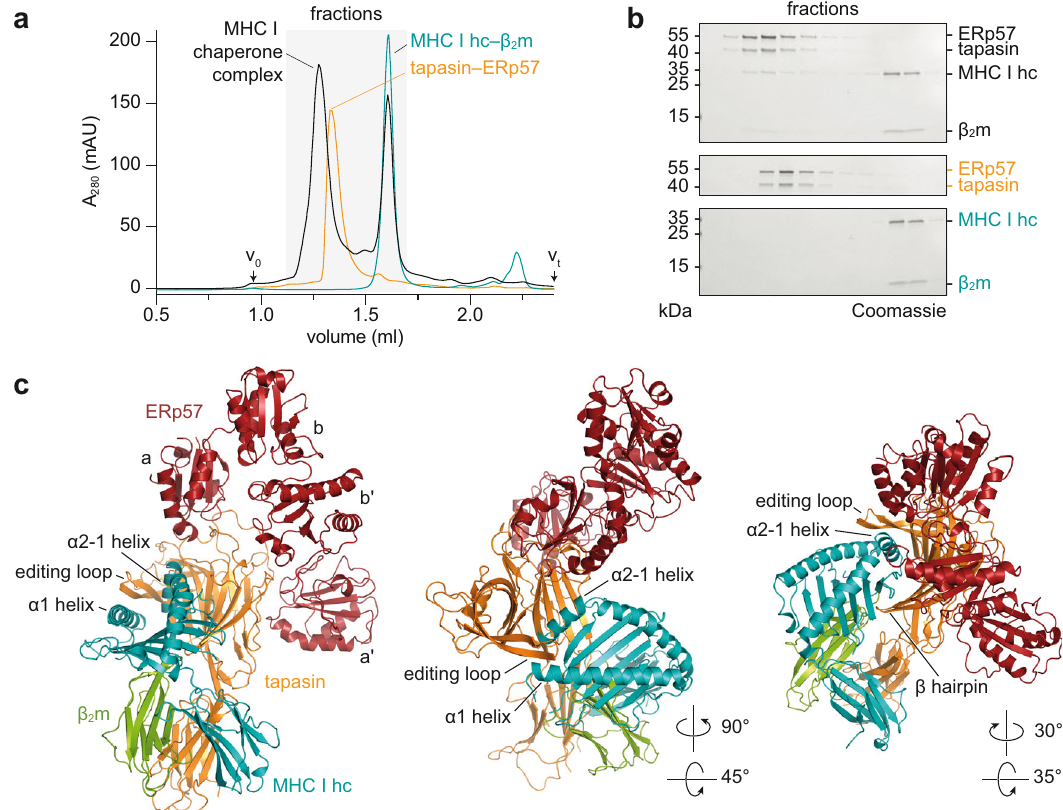
Fig. 1 | Photo-triggered assembly and structural overview of the MHC I – tapasin – ERp57 complex. a Photo-triggered assembly of a transient MHC I – tapasin – ERp57 complex (black) analyzed by size exclusion chromatography (SEC). SEC elution pro fi les of tapasin – ERp57 and MHC I hc – β 2 m are colored in orange and teal, respectively. β 2 m β 2 -microglobulin; hc heavy chain; A 280 absorption at 280nm; V 0 void volume; V t total volume. b MHC I – tapasin – ERp57